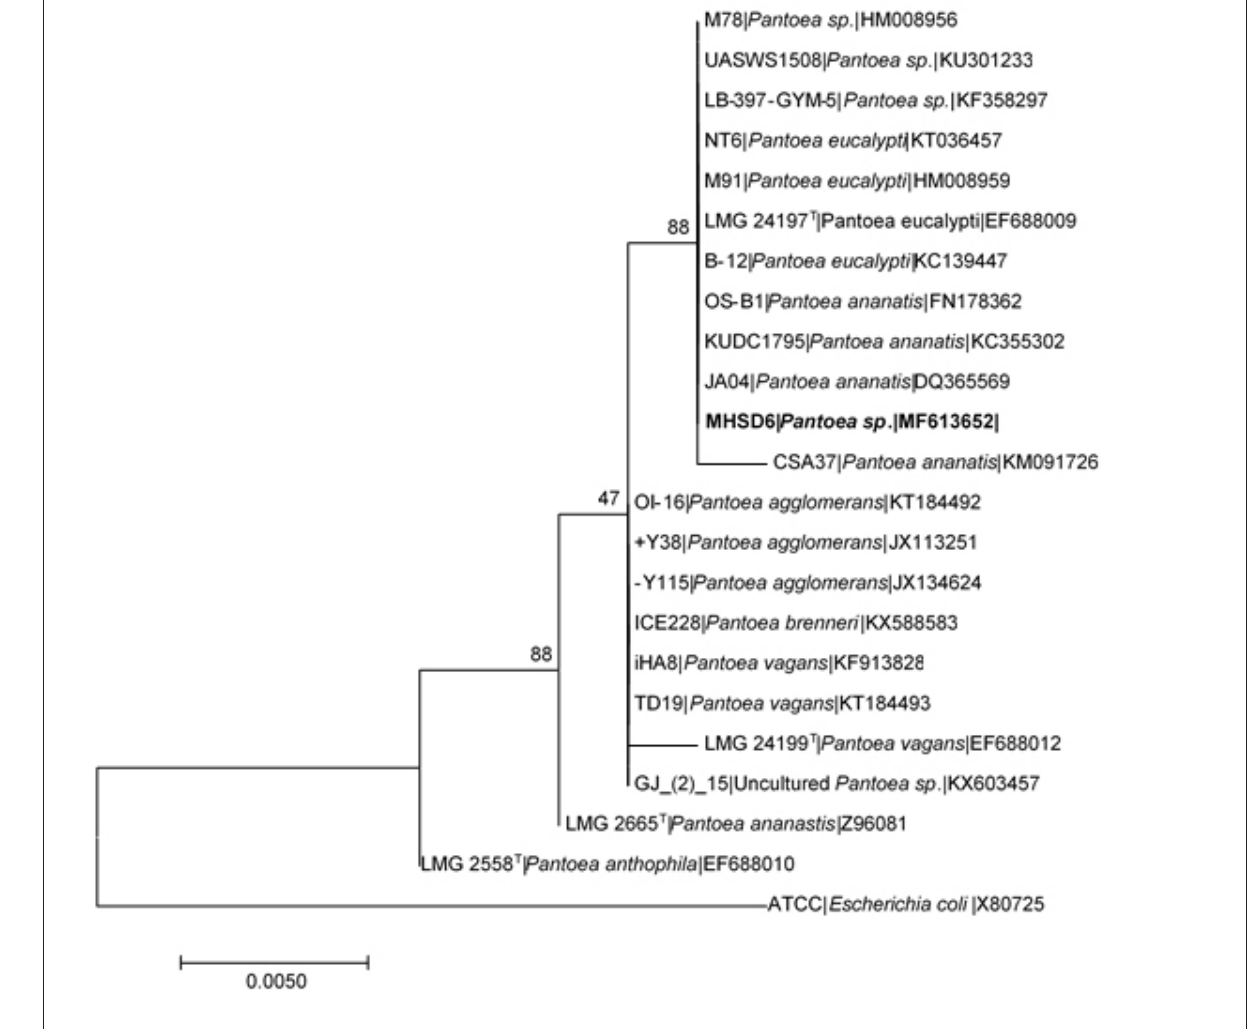
Figure 6: Maximum likelihood tree based on the 16S rRNA gene sequences of Pantoea sp . MHSD6 and its closest phylogenetic neighbours. The numbers on nodes indicate bootstrap values after 1000 replicates expressed in percentages. Escherichia coli strain ATCC X80725 was included as an outgroup. T indicates type strains.